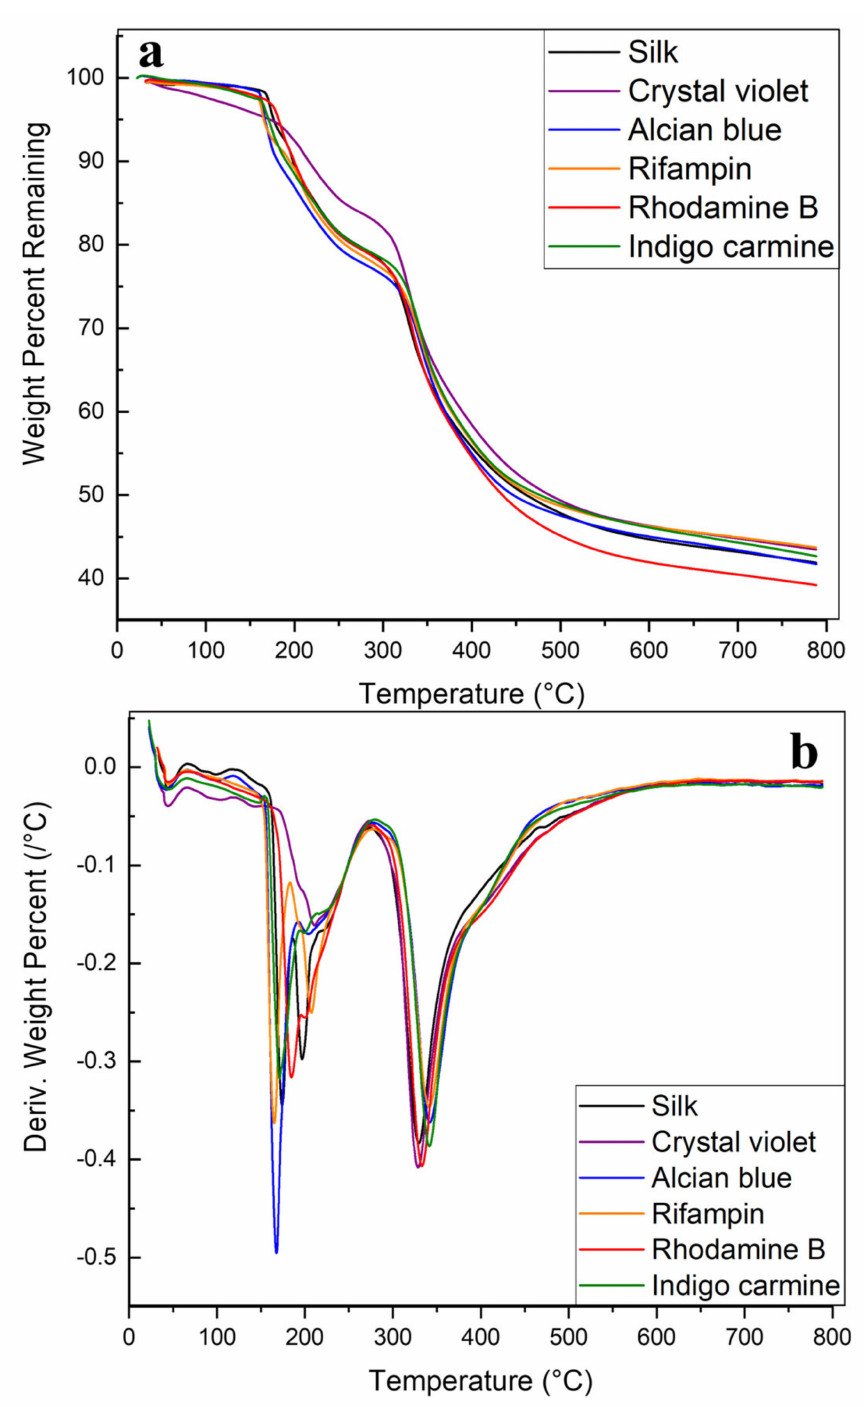
Figure 4. TGA thermograms of silk and silk-model drug thin films. ( a ) Remaining weight percent of silk and silk-model drug thin films as they were heated to 800 ◦ C. ( b ) Derivative of remaining weight percentage